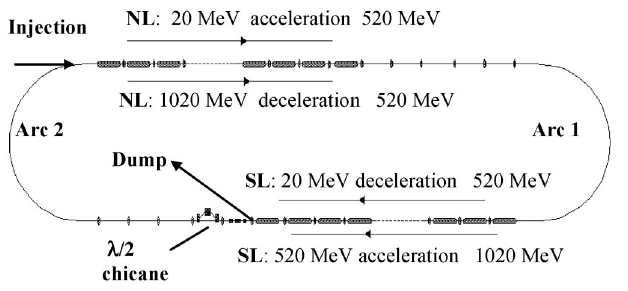
FIG. 1. CEBAF energy recovery experiment at JLab.